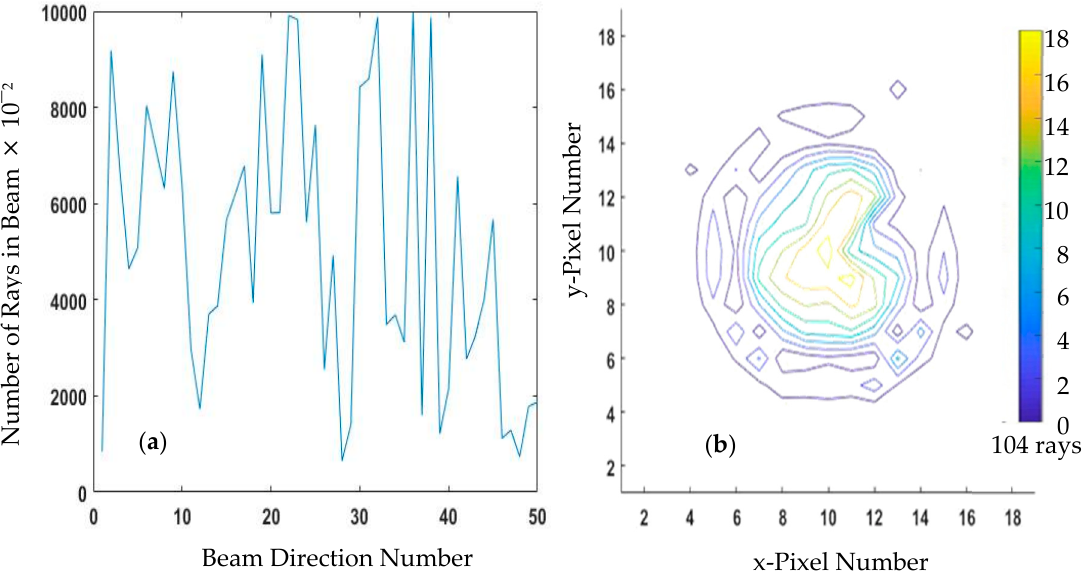
Figure 9. ( a ) A typical scene power distribution over 50 directions, and ( b ) the corresponding distribution of rays on the readout array.